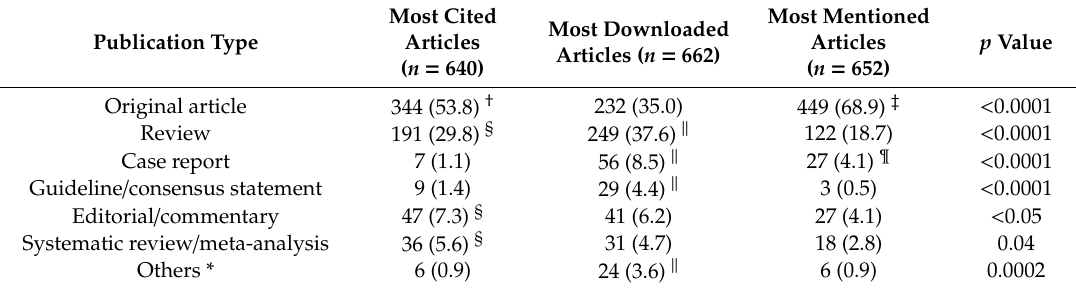
Table 2. Publication type of the most cited, most downloaded, and most mentioned articles published in general medical